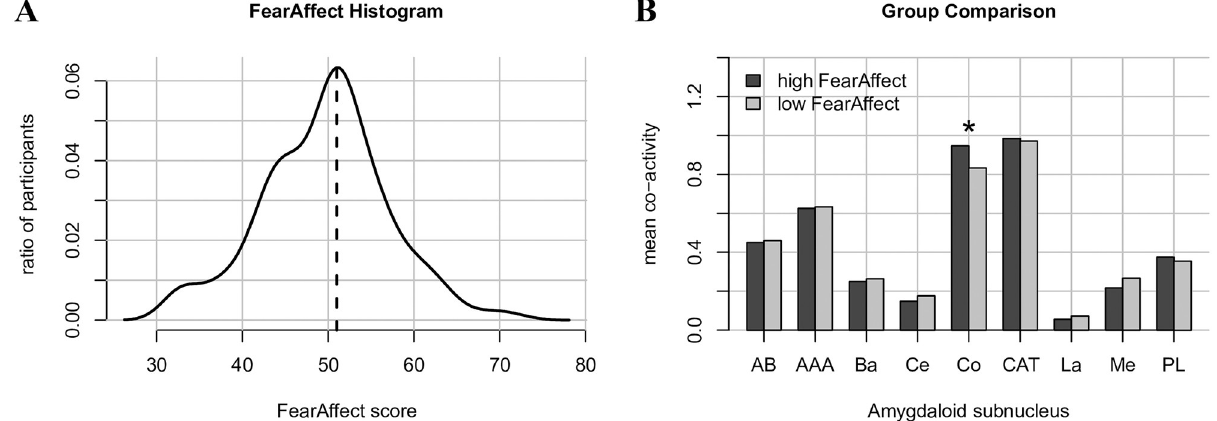
Fig 7. Results from fear affect analyses. Distribution of Fear Affect scores (A) with low and high FearAffect groups defined by the median value (indicated by the vertical line), and marginal means of co-activity scores between the low and high fear group for each amygdaloid nucleus. � indicates significant difference (p <